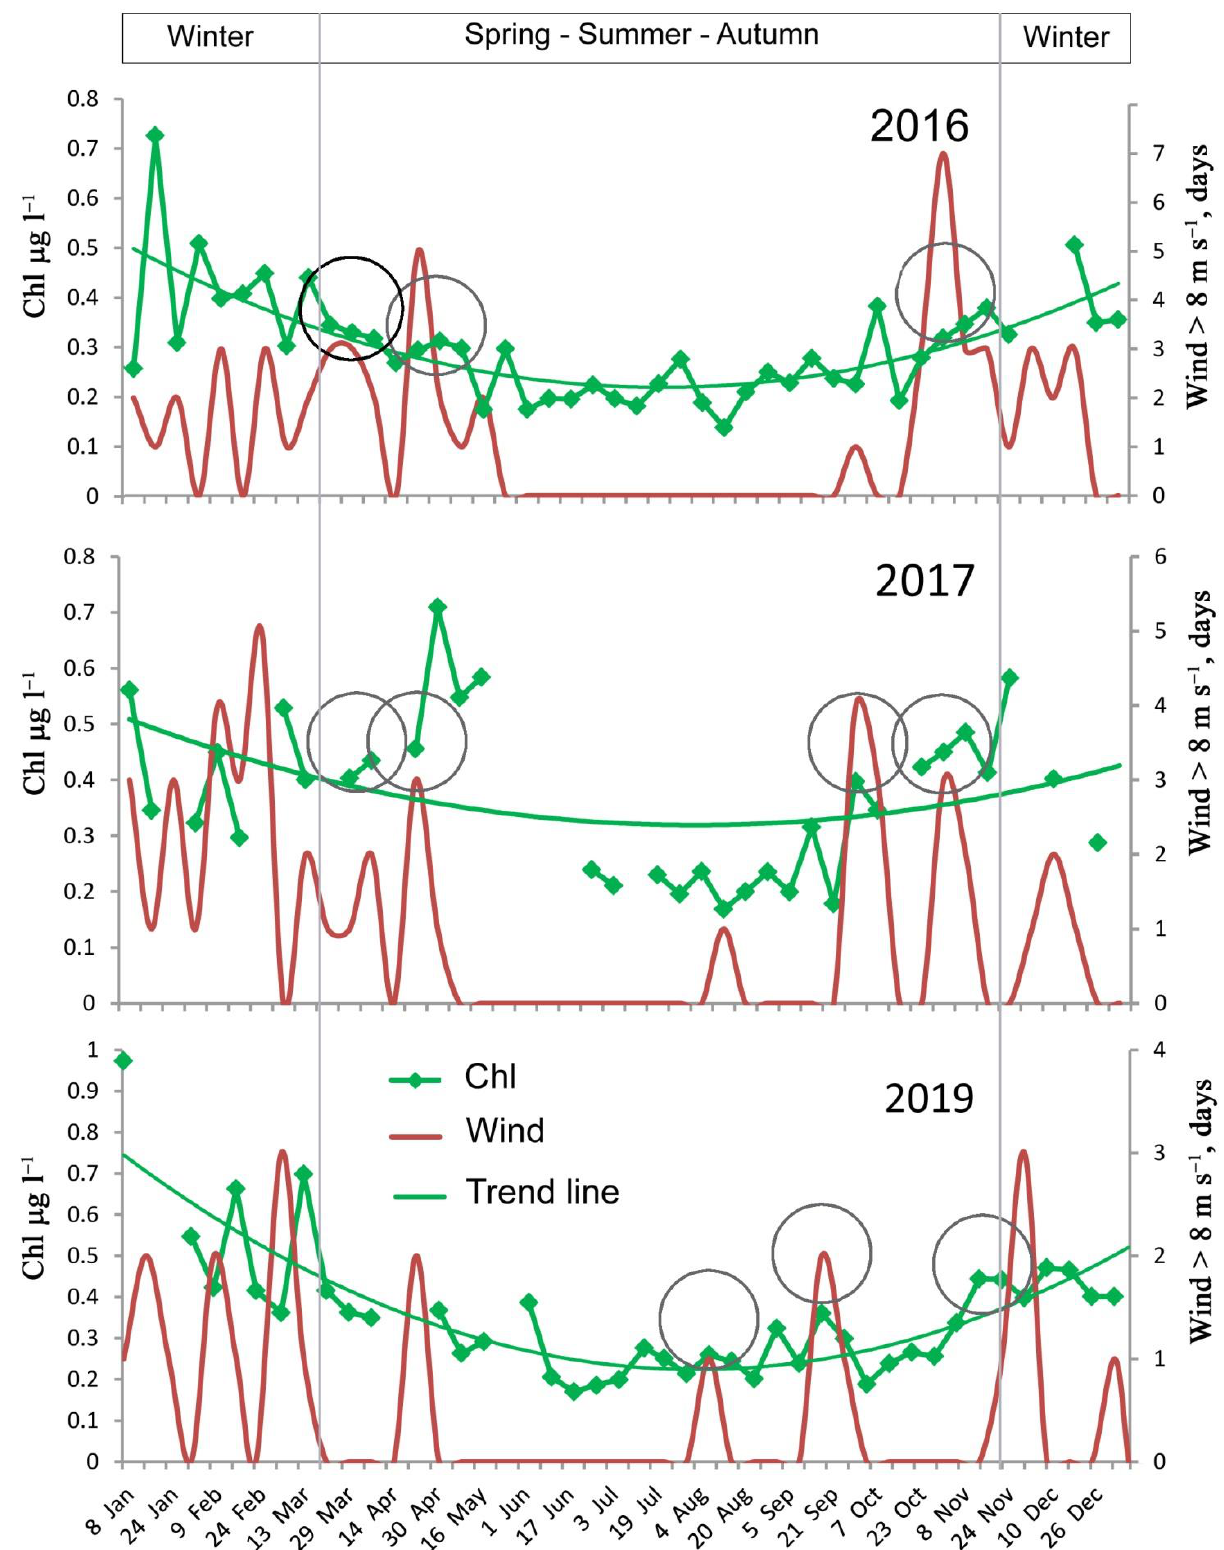
Figure 3. Seasonal dynamics of chlorophyll-a (Chl) concentration against the background of strong wind (number of days with wind > 8 m s −1 in an 8-day period) during 2016, 2017, and 2019. The trend line is a polynomial function. Vertical gray lines show the boundaries between hydrological periods with a non-stratified (winter) and stratified (spring, summer, autumn) water column. Cycles indicate the coincidence of strong wind effects and Chl increases above the annual trend line.